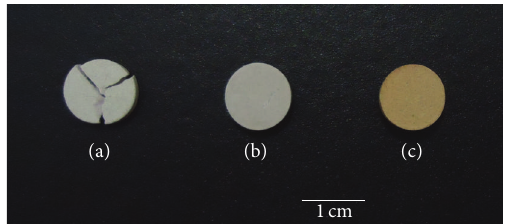
Figure 4: Preparation of coal fly ash ceramics: (a) fracture in pellet compacted at 198.98 MPa; (b) pellet compacted at 318.30 MPa; and (c) ceramic prepared with pellet compacted at 318.30